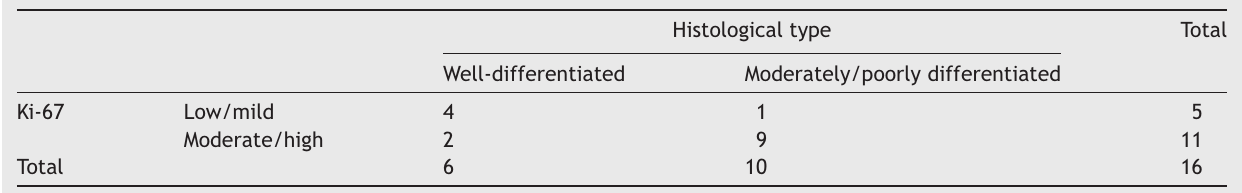
Distribution of cases according to histological type and cell